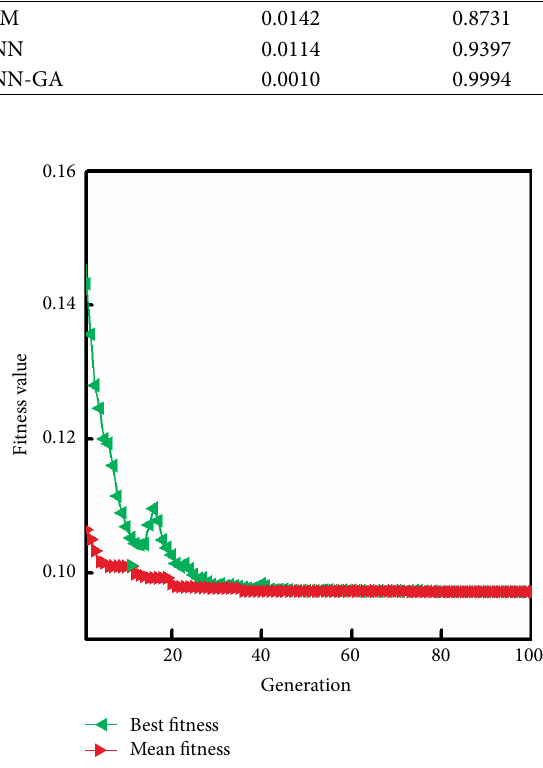
Figure 8: Evolution of fitness value in 100 generations.